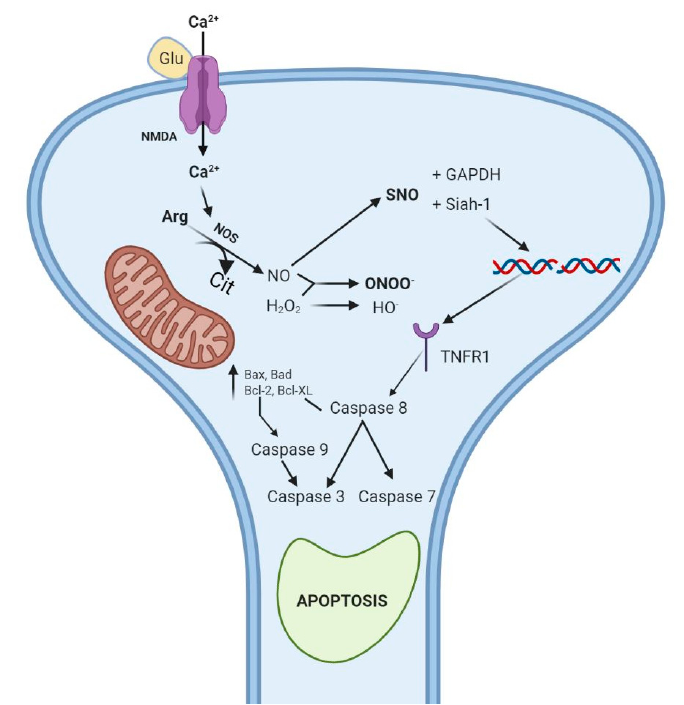
specific dopamine transporter (DAT) and norepinephrine (NET) transporters in medial prefrontal cortex (mPFC). NA in the synaptic cleft stimulates α 1 ( α 1 R) receptors in DA neurons by promoting the release of endocannabinoids (2-arachidonoylglycerol, 2AR) which, after binding to CB 1 R re- ceptors, inhibit gamma-aminobutyric acid (GABA) release in the synaptic cleft. A lower concentra- tion of GABA promotes the release of glutamate (GLU) due to the suppression of the inhibitory effect of GABA on the release of GLU. Created with BioRender.com